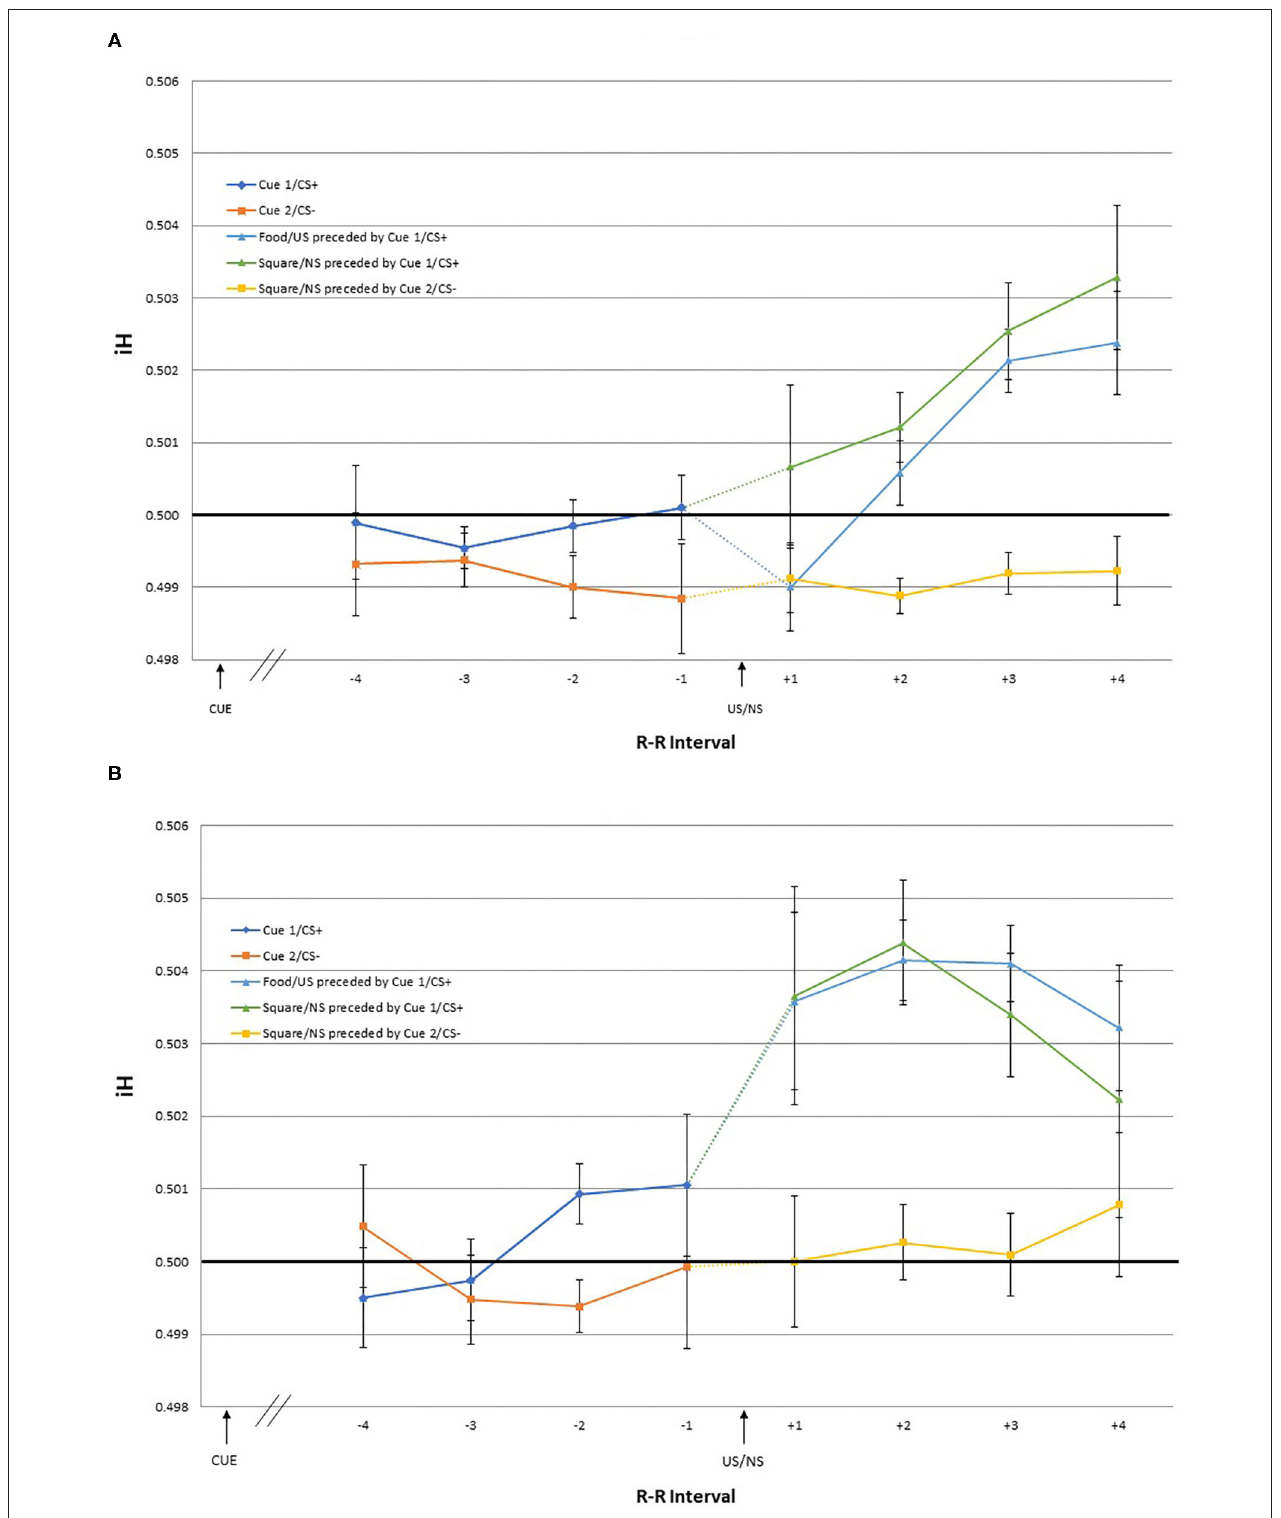
FIGURE 2 | The mean iH values and within-subject standard errors for the first through fourth interval before US onset [separated by preceding cue type: Cue 1/CS + (blue) and Cue 2/CS– (orange)], and the first through fourth interval after US onset [separated by the cue and US type; Food/US preceded by Cue 1/CS + (light blue), Square/NS preceded by Cue 2/CS + (green), and Square/NS preceded by Cue 2/CS– (yellow)] during the (A) training and (B) test phase.